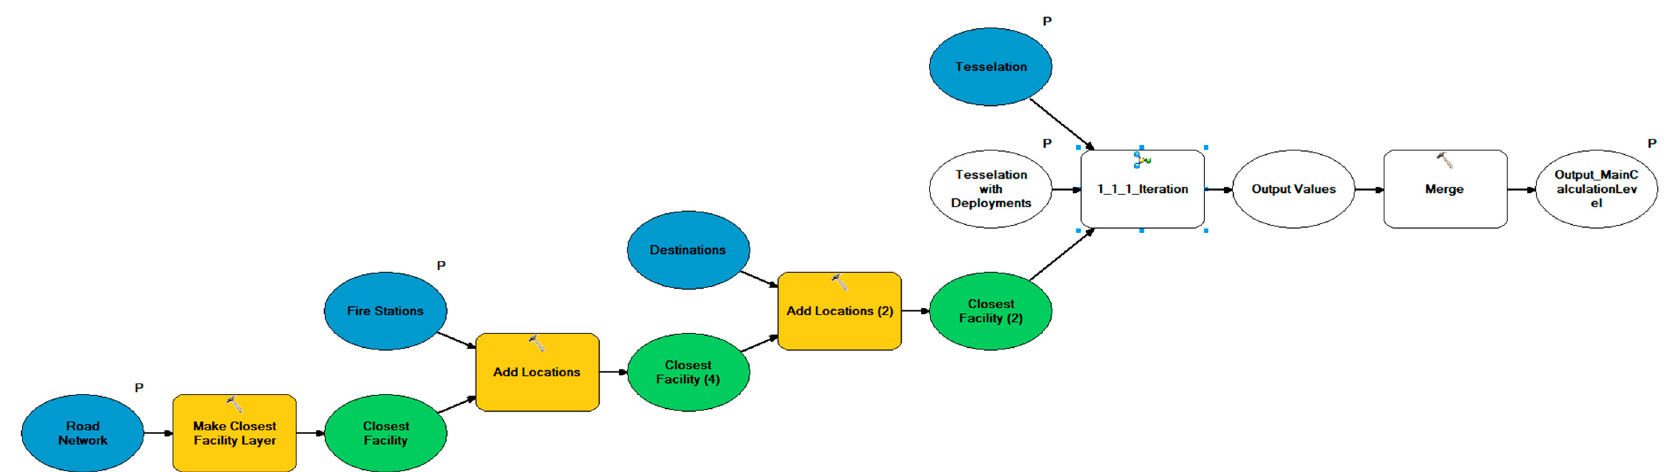
Figure A2. Main Calculation Level (CF_Hauptteil) in ArcMap